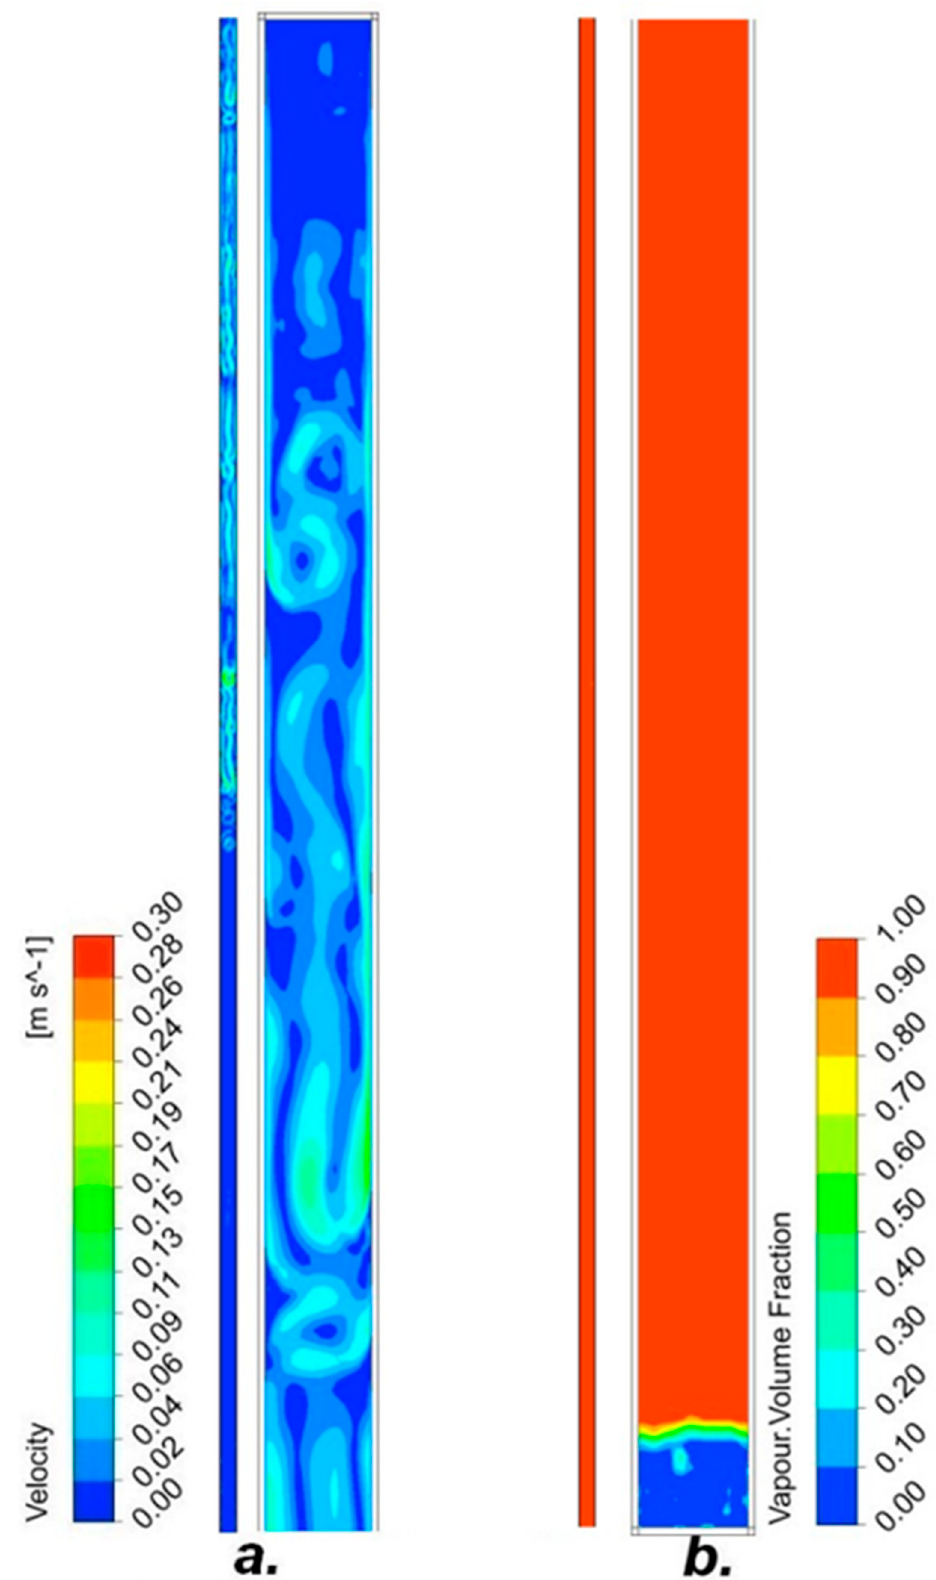
Figure 18. ( a ) Fluid velocity in the total heat pipe and in the condenser section, ( b ) the volume fraction of steam in the total heat pipe and in the evaporator section.